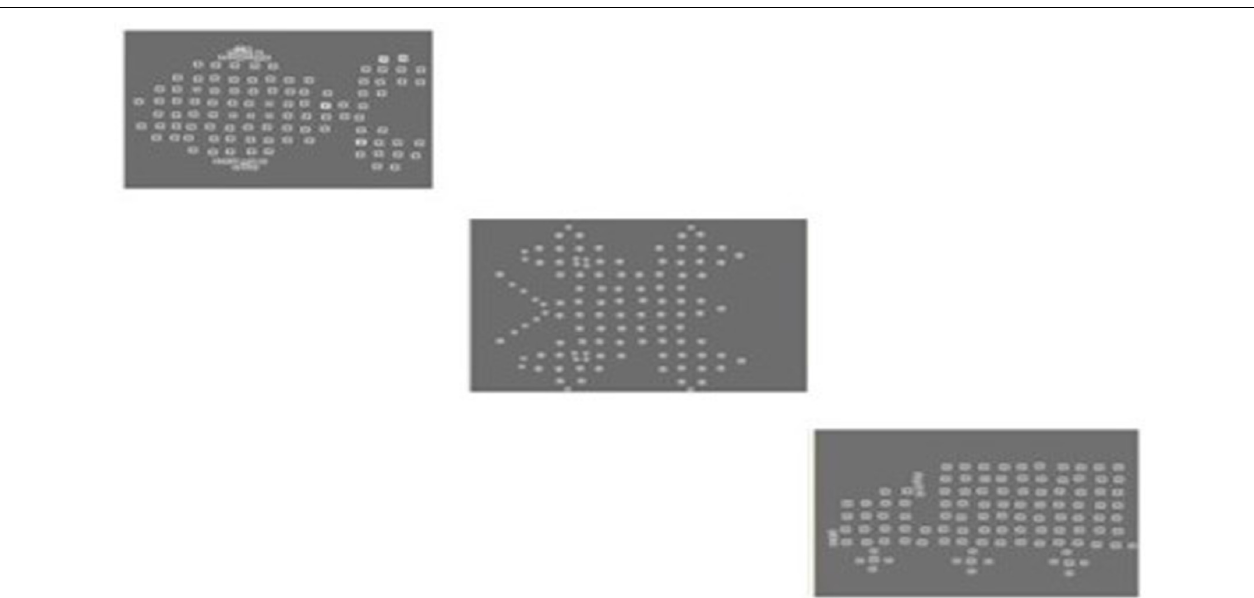
FIGURE 1 | The fish, butterfly, truck (FBT) Inspection Time task consisting of three images rapidly and randomly presented.